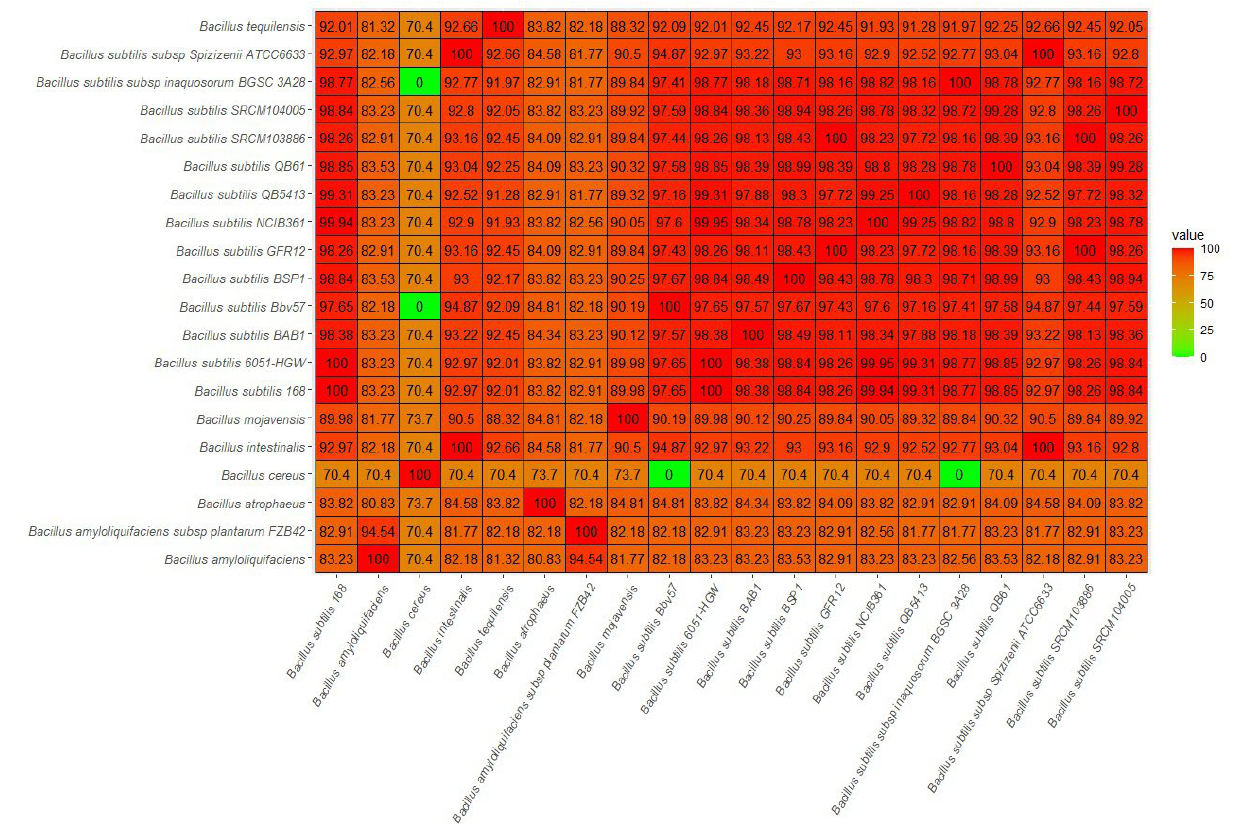
Figure 1. Heatmap of average nucleotide identity (ANI) values for whole genomes of the strain Bacillus subtilis Bbv57 and 19 other Bacillus species.